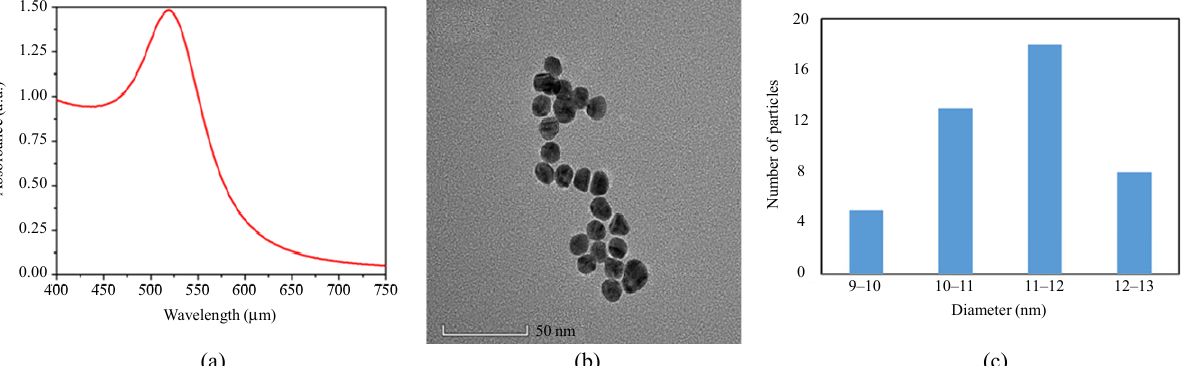
Fig. 8 Characterizations of gold nanoparticles: (a) absorbance spectrum, (b) TEM image, and (c) histogram showing the average size of gold nanoparticles is 11 ± 0.2 nm.